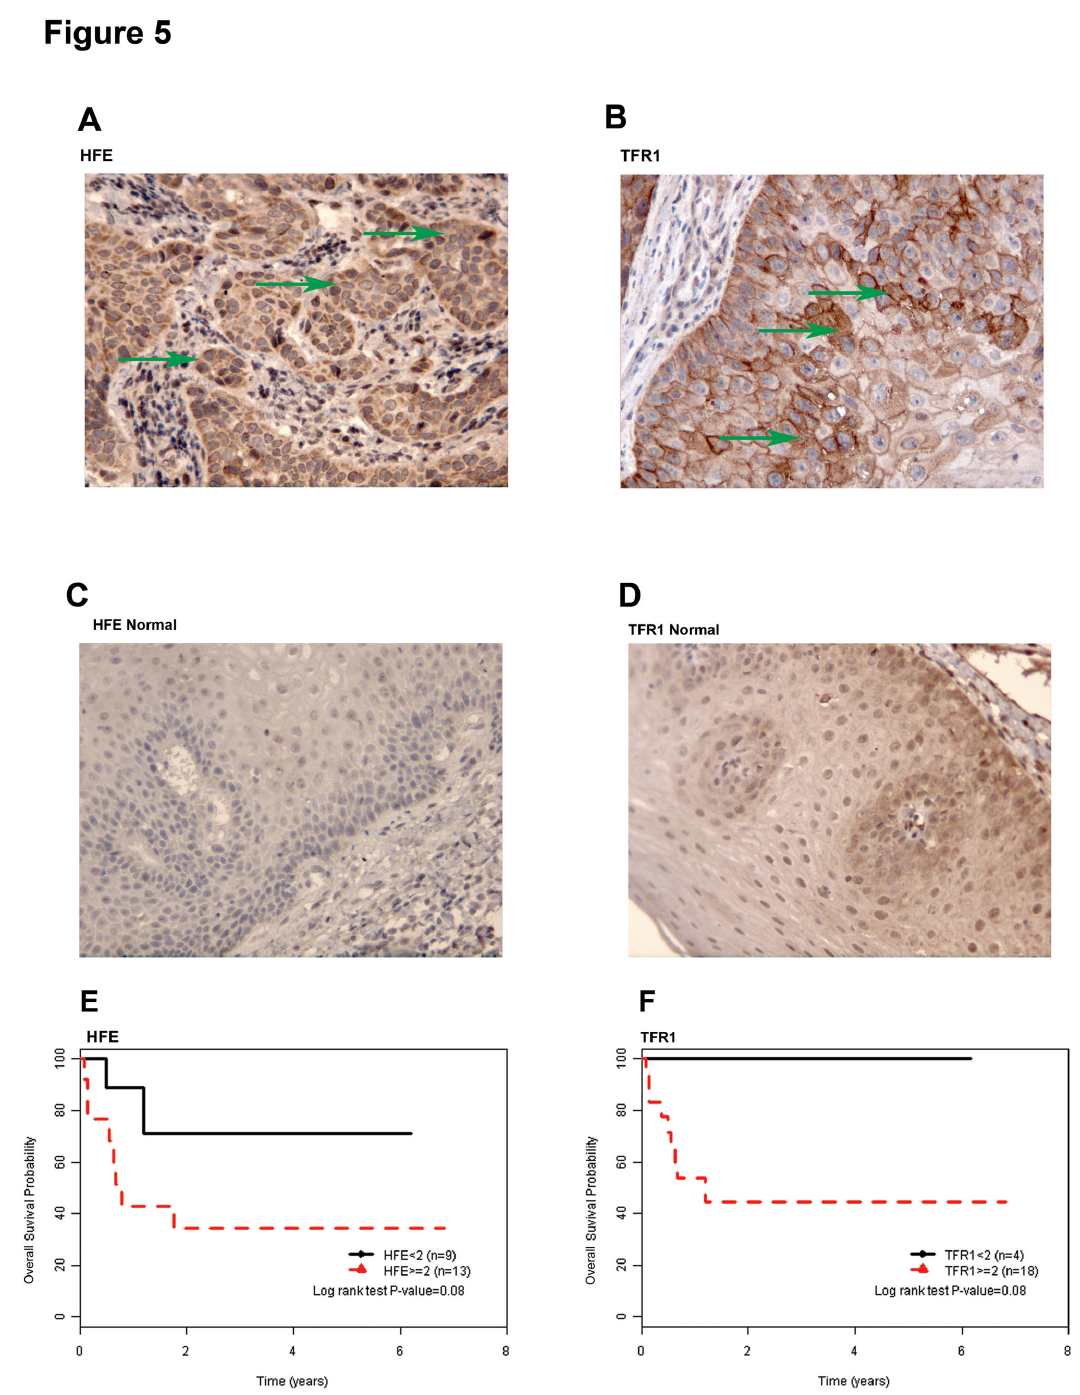
Figure 5. HFE and TFR1 expression in HNSCC patient samples. (A) A representative image of HFE immunohistochemical expression from a primary HNSCC biopsy; arrows indicating tumor cells exhibiting cytoplasmic signal. (B) A representative image of TFR1 immunohistochemical expression from a primary HNSCC biopsy; arrows indicating tumor cells exhibiting cytoplasmic membrane signal. (C) A representative image of HFE immunohistochemical expression from a normal larynx. (D) A representative image of TFR1 immunohistochemical expression from a normal larynx. (E) Kaplan-Meier plot of overall survival for HNSCC patients dichotomized based on high (≥2) vs . low (<2) HFE immunohistochemistry scores. (F) Kaplan-Meier plot of overall survival for HNSCC patients dichotomized based on high (≥2) vs . low (<2) TFR1 immunohistochemistry scores. doi: 10.1371/journal.pone.0074075.g005 PLOS ONE |